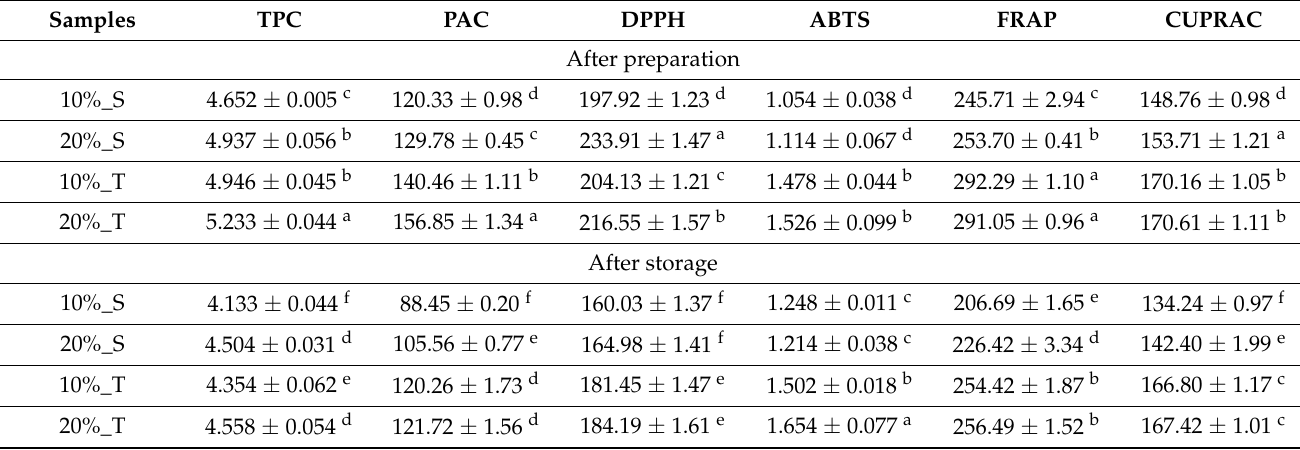
Table 6. Total phenolics content (TPC), proanthocyanidins content (PAC) and antioxidant activities of citrus fiber/blackberry gels prepared with different disaccharides after preparation and